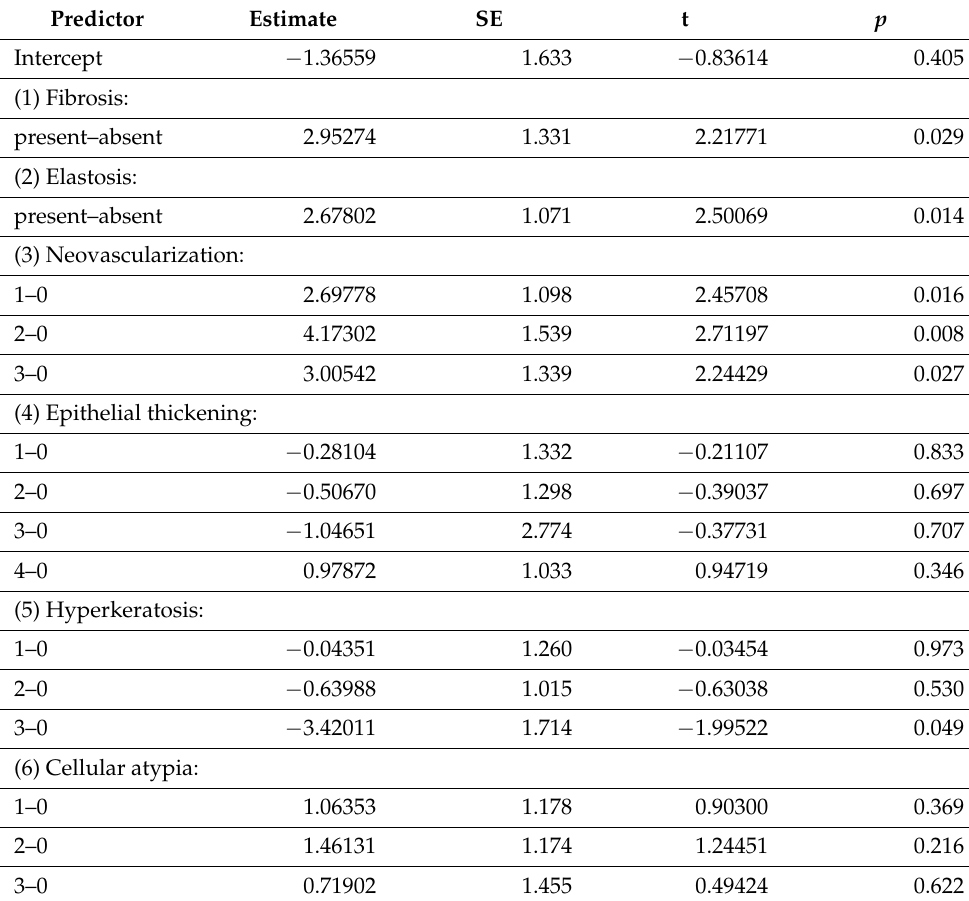
Table 14. Results of multiple linear regression including all histological variables as predictors. Dependent variable: AF intensity ratio. Predictor